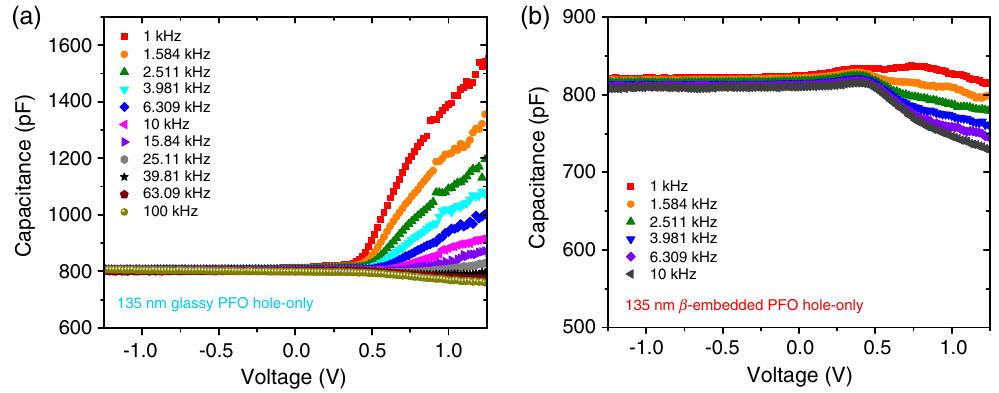
FIG. 24. Frequency-dependent C − V characteristics of (a) glassy and (b) β -embedded 135-nm asymmetric HMW PFO hole-only devices. Positive voltage means applying positive potentials to the Au = MoO